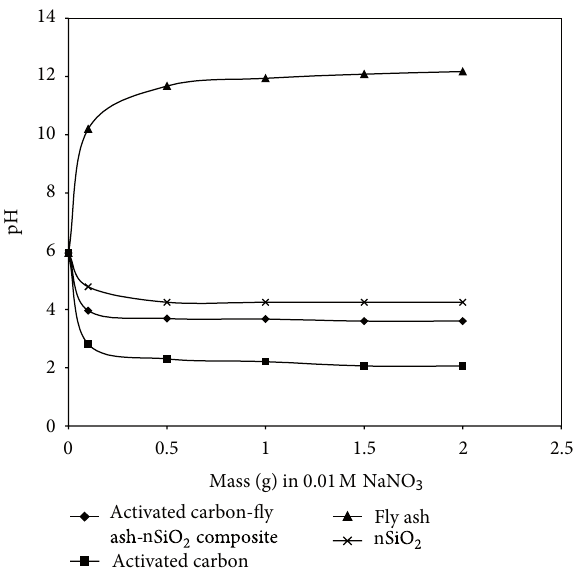
F 16: Result of mass titration experiments with activated carbon, �y ash, and activated carbon-�y ash composite material. Variation of pH versus mass of solid in 0.01M NaNO